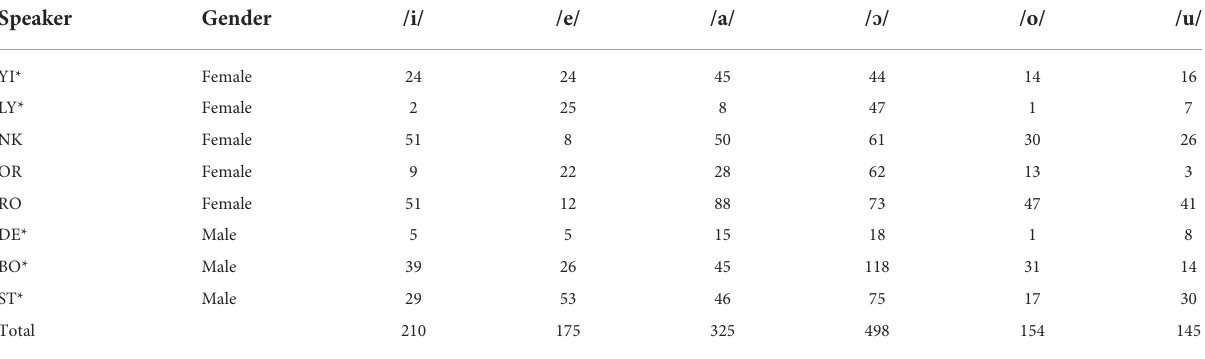
TABLE 3 Number of tokens for each vowel, by speaker, in the MONO